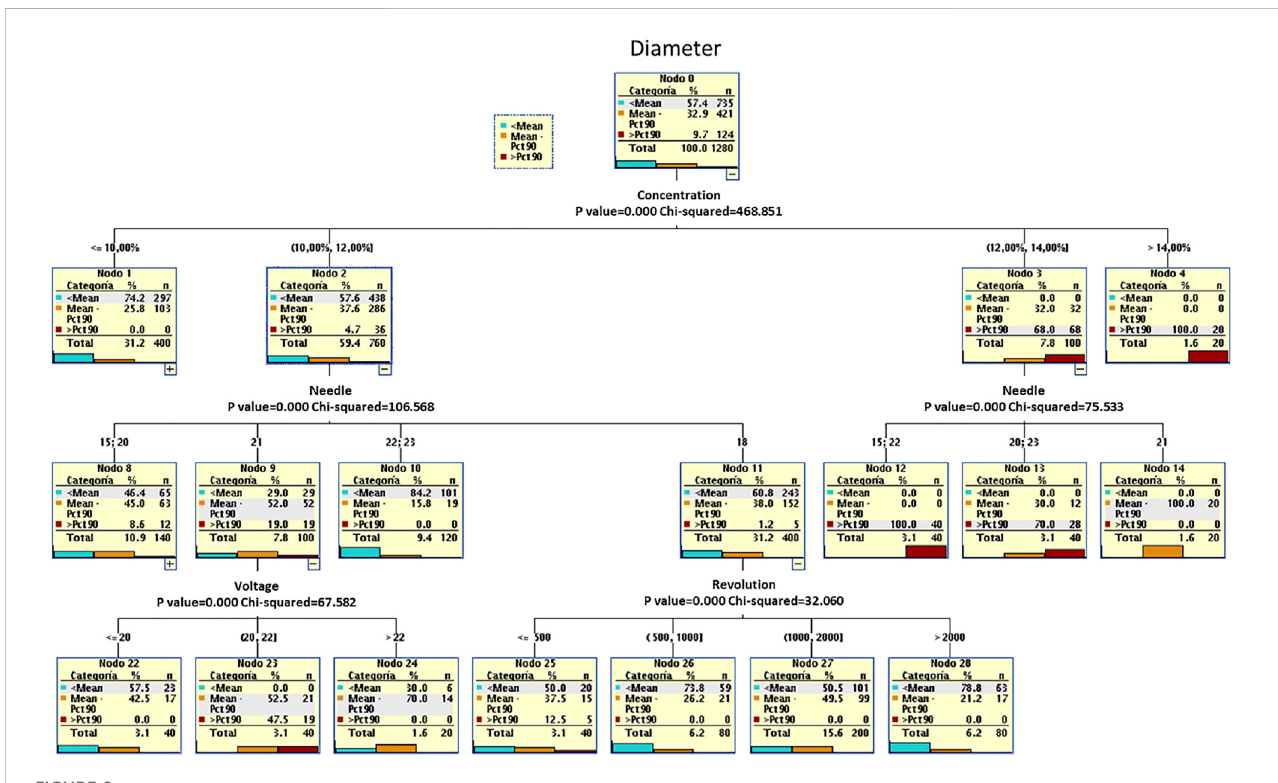
FIGURE 2 Decision tree to predict the diameter of the fi bres based on the most relevant variables.